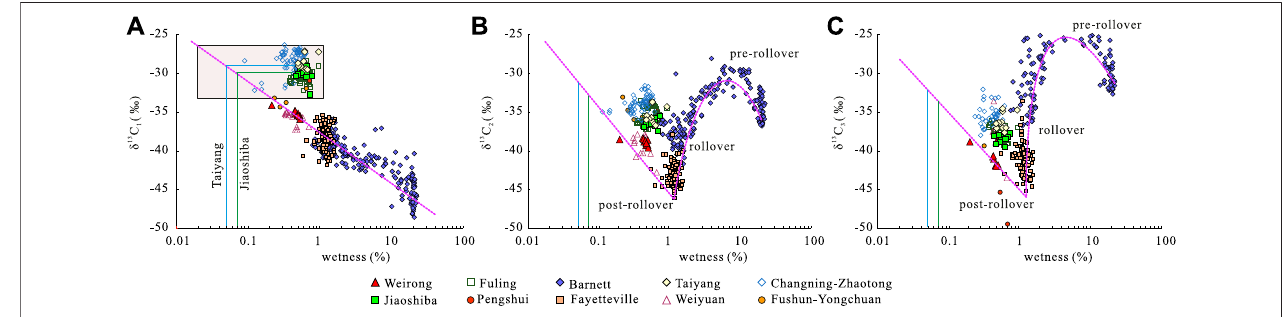
FIGURE7| Plotsofwetnessversus δ 13 C 1 (A) , δ 13 C 2 (B) ,and δ 13 C 3 (C) ofshalegasesfromTaiyang,Jiaoshiba,andWeironggas fi elds.Alsoshownareshalegases from the published data (see text).